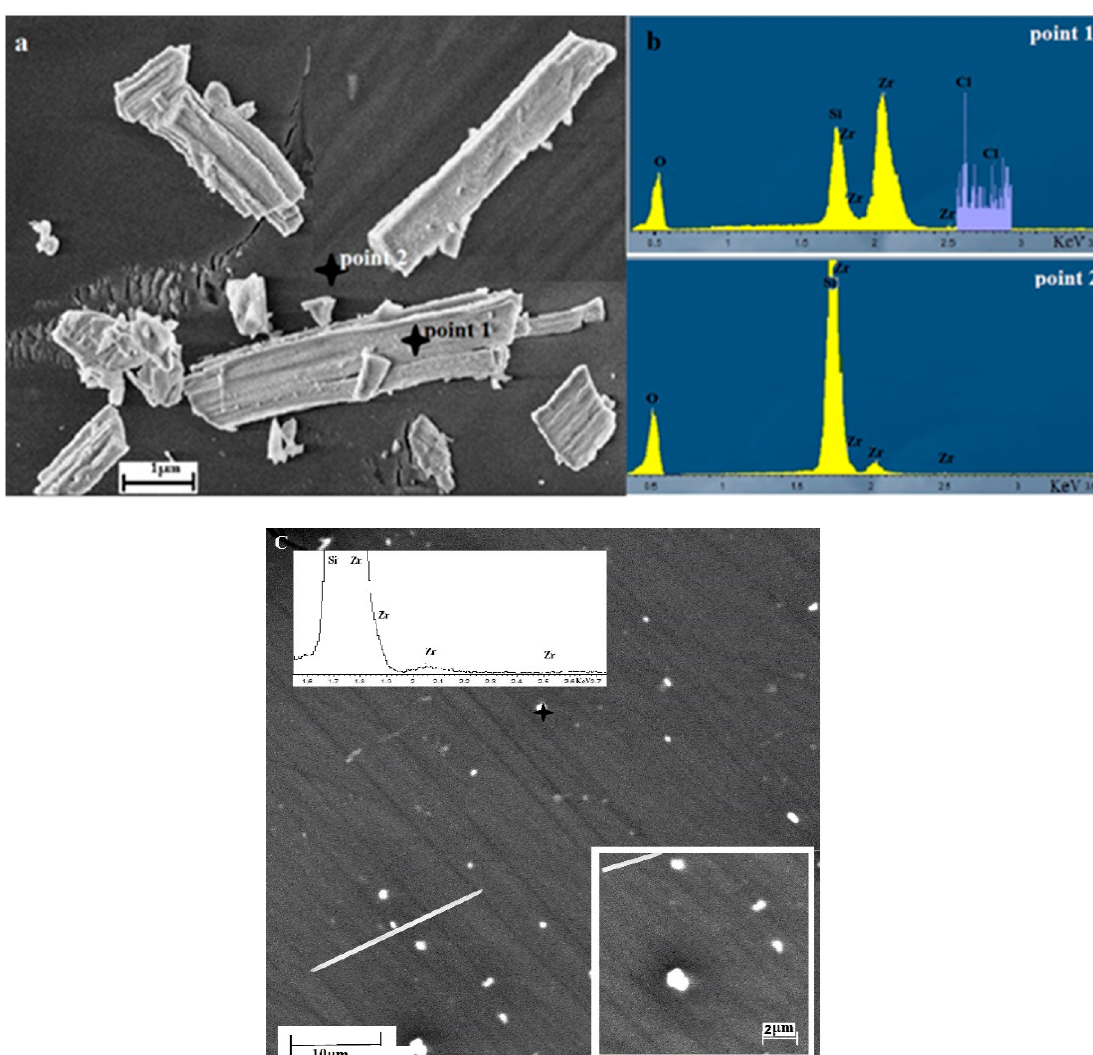
Figure 3. Scanning electron microscopy (SEM) micrograph of the typical surface morphology ( a ); combined energy dispersive X-ray (EDX) and WDX spectra of crystallites (point 1), and EDX analysis of films surface (point 2) ( b ); the SiO 2 ZrO 2 films thermally treated at 500 °C; SEM micrograph and EDX spectrum (insert) of the SiO 2 ZrO 2 films thermally treated at 200 °C ( c ).